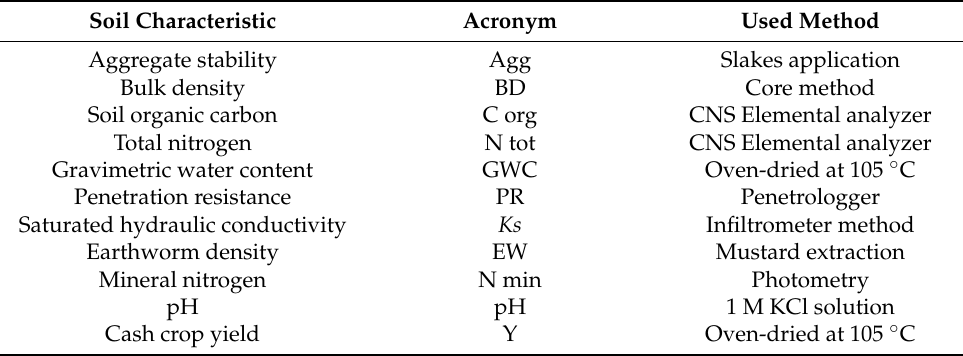
Table 1. Soil parameters used for building the sustainability